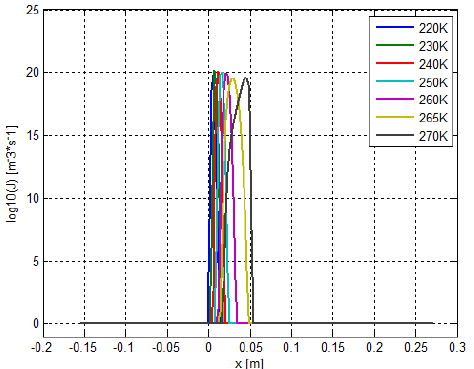
Figure 13. Nucleation rate curves along the axial cross-section of the supersonic separator at temperatures 220, 230, 240, 250, 260, 265, and 270 K.